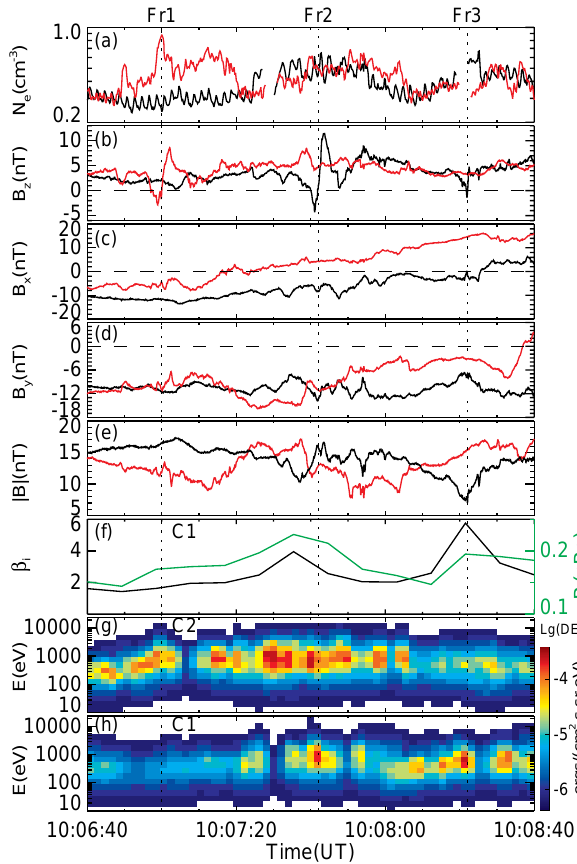
Fig. 2. (a) electron density derived from the spacecraft potential, magnetic field components (b) B z , (c) B x , and (d) B y , and (e) mag- netic field magnitude | B | at C1 and C2, (f) ion beta (black) and ion pressure (green), and electron energy-time spectra at (g) C2 and (h) C1 during the interval 10:06:40–10:08:40UT are presented.